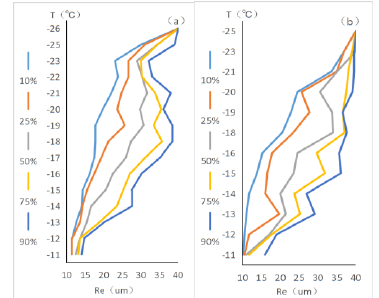
Figure 5. T-Re profiles (left:17:38 LST, right:17:53